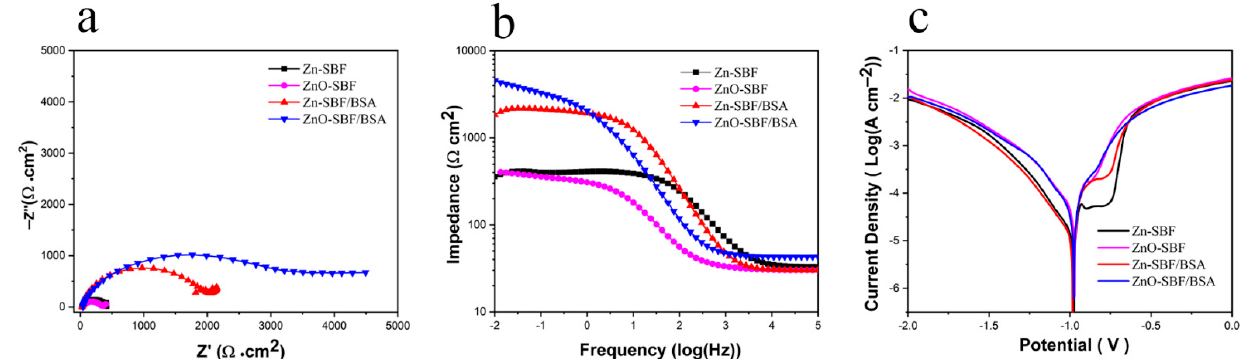
Figure 5. Electrochemical measurements for Zn and Zn/ZnO in SBF and SBF/BSA: ( a ) EIS: Nyquist plots, ( b ) EIS: Bode plots; ( c ) Potentiodynamic polarization curves.